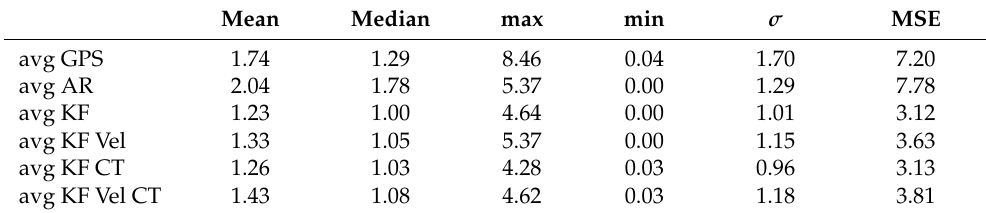
Table 1. Evaluation (Dataset 1): GPS and AR; distance to ground truth.